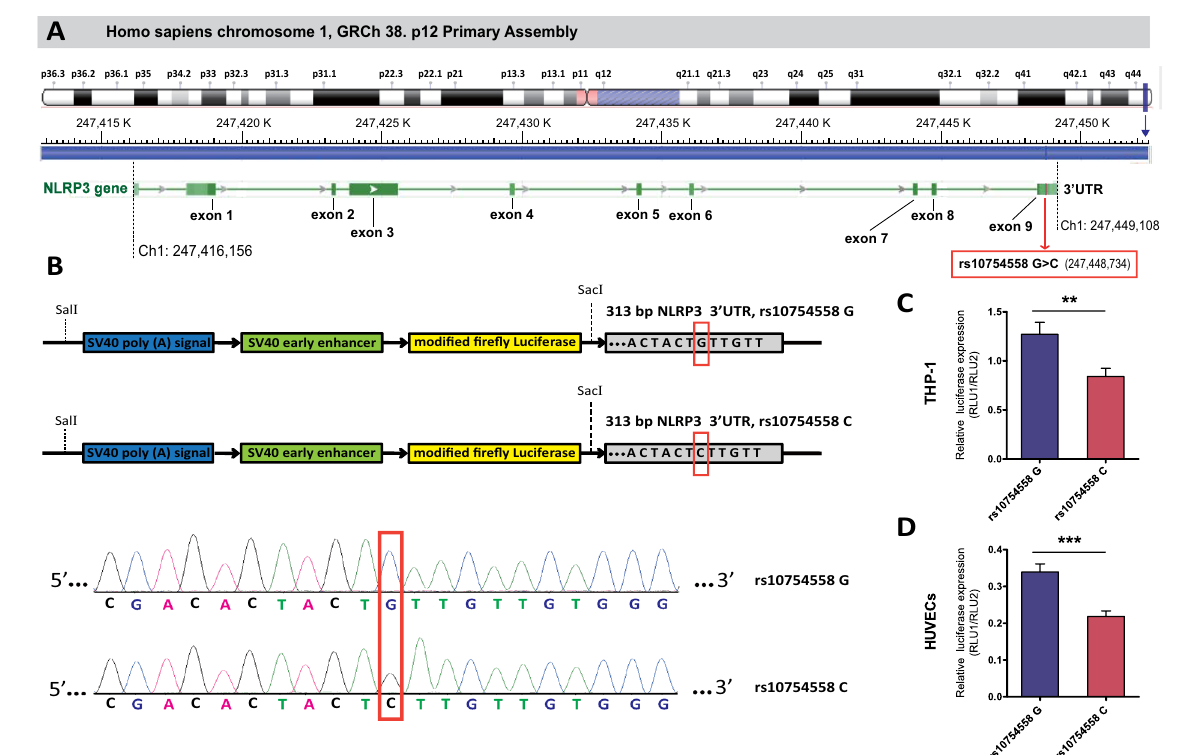
Figure 5. The location of functional rs10754558 polymorphism in NLRP3 gene and its effect on the post- transcriptional regulation of NLRP3 expression. ( A ) The human NLRP3 gene is encoded in Homo sapiens chromosome 1 q44 (247416156–247449108) containing 9 coding exons (shown as bottle green bars), and the rs10754558 polymorphism within 3 ′ UTR of NLRP3 gene is located at chromosome 1 (247448734); ( B ) A fragment with 313 bp length in the 3 ′ UTR region of NLRP3 containing rs10754558 G-to-C mutantion was amplified and cloned into pmirGLO luciferase reporter vectors; ( C , D ) After 48-h of transfection, the transcriptional enhancer activities of rs10754558 in HUVEC and THP-1 cells were detected using dual- luciferase report assays. Firefly luciferase signals were normalized with Renilla luciferase signals. Bar graphs indicate the mean ± SEM for a minimum of three independent experiments. ** p < 0.01, *** p < NLRP3‑29940G>C is a gain‑of‑function alteration that suppresses NLRP3 expression by alter‑ ing miR‑146a‑5p binding. As the 29940G>C polymorphism was located in the 3 ′ -UTR of the NLRP3 gene, we focused on its effect on gene interactions with miRNAs. Bioinformatics analyses predicted by miR- NASNP-v3 (http:// bioin fo. life. hust. edu. cn/ miRNA SNP/) and TargetScan (http:// www. targe tscan. org/) revealed a target binding site of miR-146a-5p enabled by the 29940 G-to-C mutation within the 3 ′ -UTR of the NLRP3 gene (Fig. 6) 27 . We next detected the miR-146a expression in 50 septic patients and 50 healthy controls. Our results showed that sepsis patients exhibited significantly lower expression level of miR-146a compared to the healthy controls (Fig. 6A). No significant differences in miR-146a expression were observed in patients with different types of sepsis or different genotypes of rs10754558 polymorphism (Fig. 6B,C). Similarly, in vitro LPS stimulation induced decreased expression of miR-146a in the PBMCs isolated from 50 healthy subjects, while differential levels of miR-146a were not detected in PBMCs with different genotypes of NLRP3 polymorphism (Fig. 6D,E). To validate the potential role of miR-146a-5p in the attenuation of NLRP3 expression mediated by the NLRP3 29940 G-to-C mutation, HUVECs and THP-1 cells were infected with LV3-miR-146a (miR-146a overexpres- sion vector) and LV3-NC (negative control) to establish a stably overexpressing cell line (Fig. 6F–H). Next, pmirGLO-NLRP3-3 ′ -UTR-29940G and pmirGLO-NLRP3-3 ′ -UTR-29940C were transfected into the cells for 48 h. As shown in Fig. 6I,J, miR-146a-5p significantly decreased the luciferase reporter activity of the pmirGLO- NLRP3-3 ′ -UTR-29940C vector, while no obvious variations were found in the pmirGLO-NLRP3-3 ′ -UTR-29940G vector. With regards to the other miRNAs predicted by miRNASNP-v3 and TargetScan, neither miR-580-3p nor miR-589-5p overexpression exerted a significant effect on the activities of the luciferase reporter vectors containing the NLRP3 3 ′ -UTR with 29940 G-to-C variation in THP-1 cells (Supplementary Fig. S1). These results indicated that NLRP3-29940G>C is a gain-of-function alteration that causes the suppression of NLRP3 expression by altering the binding of miR-146a-5p to the 3 ′ -UTR of NLRP3. However, no significant difference in NLRP3 expression was observed between THP-1 cells infected with LV3-NC and LV3-miR-146a (Fig. 6K).